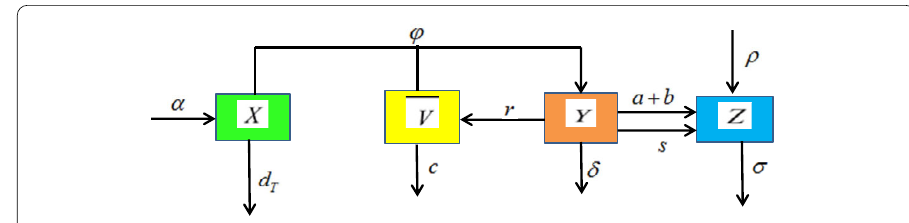
Figure 1 Compartmental diagram for HBV virus dynamics model